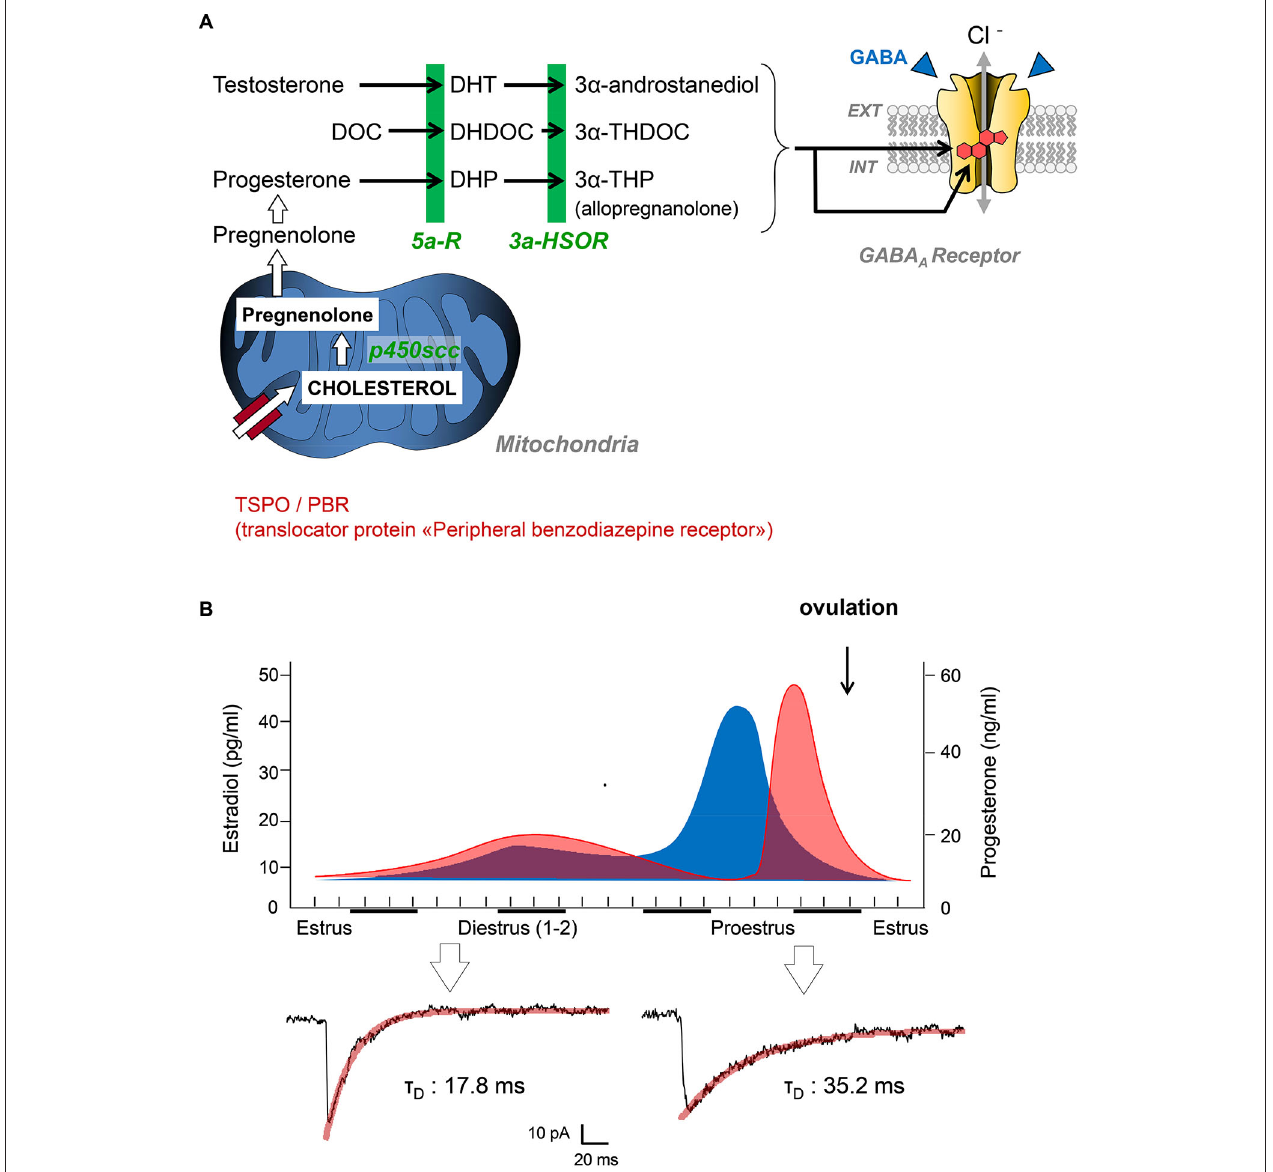
3 α -hydroxysteroid oxydoreductase; P450scc, P450 side-chain cleavage enzyme. (B) Top graphs summarize the global changes in blood estradiol (blue) and progesterone (red) during different phases of the reproductive cycle in female rats. Patch clamp traces below are representative of inhibitory postsynaptic currents mediated by GABA A Rs in the spinal cord of female Sprague-Dawley rats during estrus and proestrus (i.e., when progesterone levels are low and high, respectively). Adapted from Keller